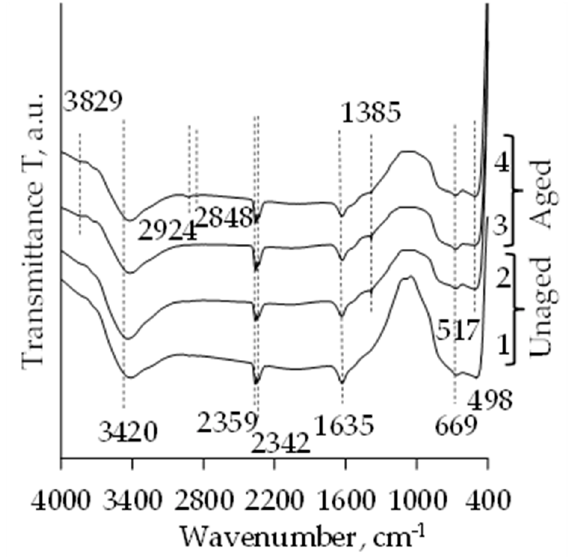
Figure 4. FT-IR spectra of subcritical dried and calcinated TiO 2 aerogels (( 1, 2 ) unaged; ( 3, 4 ) aged; 1 , 3 curves correspond to precursor TIP and 2 , 4 correspond to precursor TBOT).